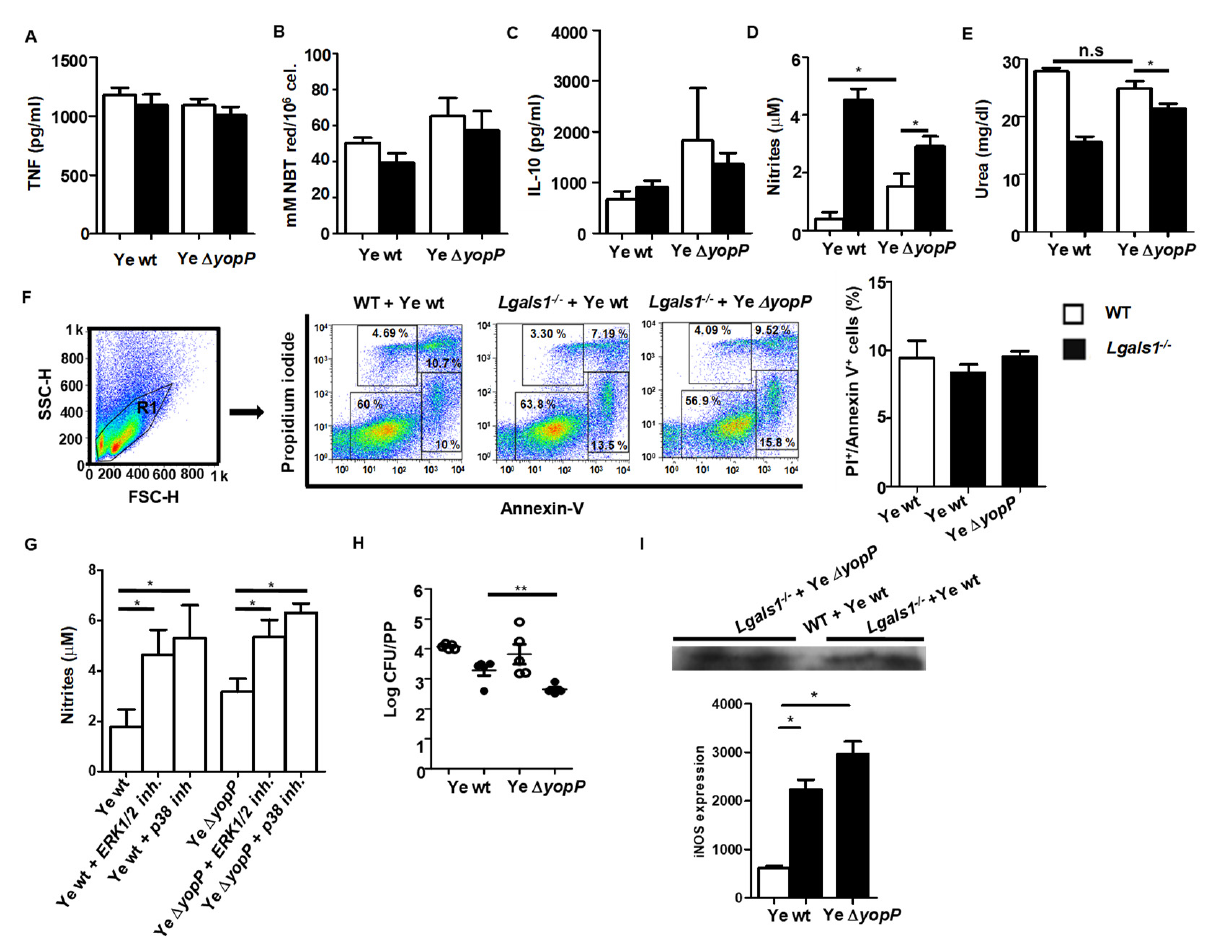
Figure 5. Lack of Gal1 and YopP induces NO Production and Confers Protection Against Ye. WT and Lgals1 − / − macrophages were infected with Ye wt or Ye ∆ yopP for 1 h. TNF and IL-10 were determined in culture supernatants by ELISA ( A , C ). Superoxide anion was determined as described in Materials and methods ( B ). NO production was measured in WT and Lgals1 − / − macrophages after Ye Wt or Ye ∆ yopP infection for 1 h ( D ). Urea was determined in culture supernatant as an indirect assessment of arginase activity ( E ). Macrophages were isolated from Lgals1 − / − or WT mice, infected in vitro with Ye wt or Ye ∆ yopP for 2 h, stained with annexin-V and propidium iodide and analyzed by flow cytometry. In the gated Region 1 (R1), the percentage of annexin-V + propidium iodide + cells are shown (right panel) ( F ). NO production in macrophages infected in vitro with Ye wt or Ye ∆ yopP in the absence or presence of ERK1/2 or p38 inhibitors ( G ). CFU were evaluated in PPs of mice infected with Ye wt or with Ye ∆ yopP after 5 days. Limit of detectable CFU was 25 (log 10 25 = 1.4) ( H ). After infection, macrophage lysates were analyzed by Western blot using specific antibodies against iNOS ( I ). Data are the mean ± SEM of three independent experiments ( A – F right panel and I bottom panel), representative of three independent experiments ( F left panel and I upper panel) or representative of two independent experiments ( H , n = 5 mice per group). * p < 0.05, ** p <